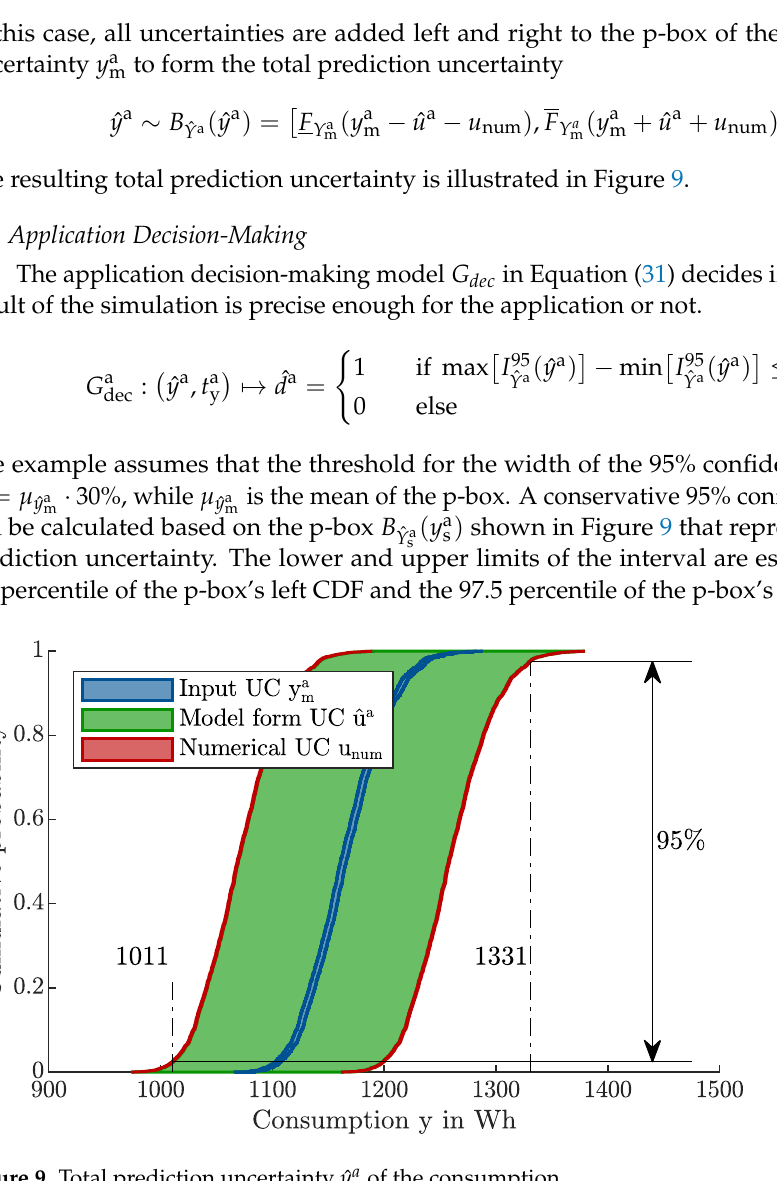
Figure 9. Total prediction uncertainty ˆ y a of the